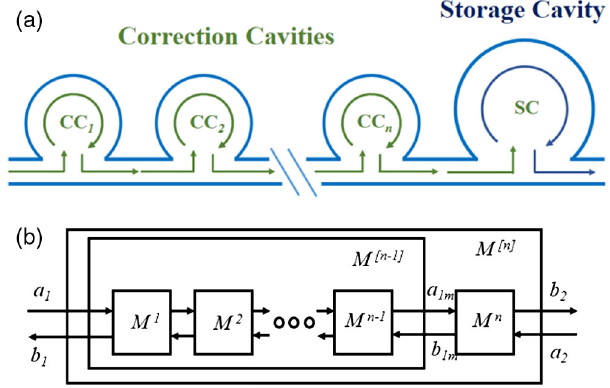
FIG. 3. Typical transmission spectrum of the pulse compressor with correction cavities. The number of the correction cavities in this case is 8 and all of them have the same unloaded Q-factor of 4 . 5 × 10 4 and coupling coefficient of 1.5. Furthermore, the unloaded Q-factor of the storage cavity is 1 . 77 × 10 5 with a coupling coefficient of 5.98. The central frequency of the spectrum is 11.994 GHz and the frequency difference between two nearby peaks is 4 MHz, which corresponds to the pulse length of 250